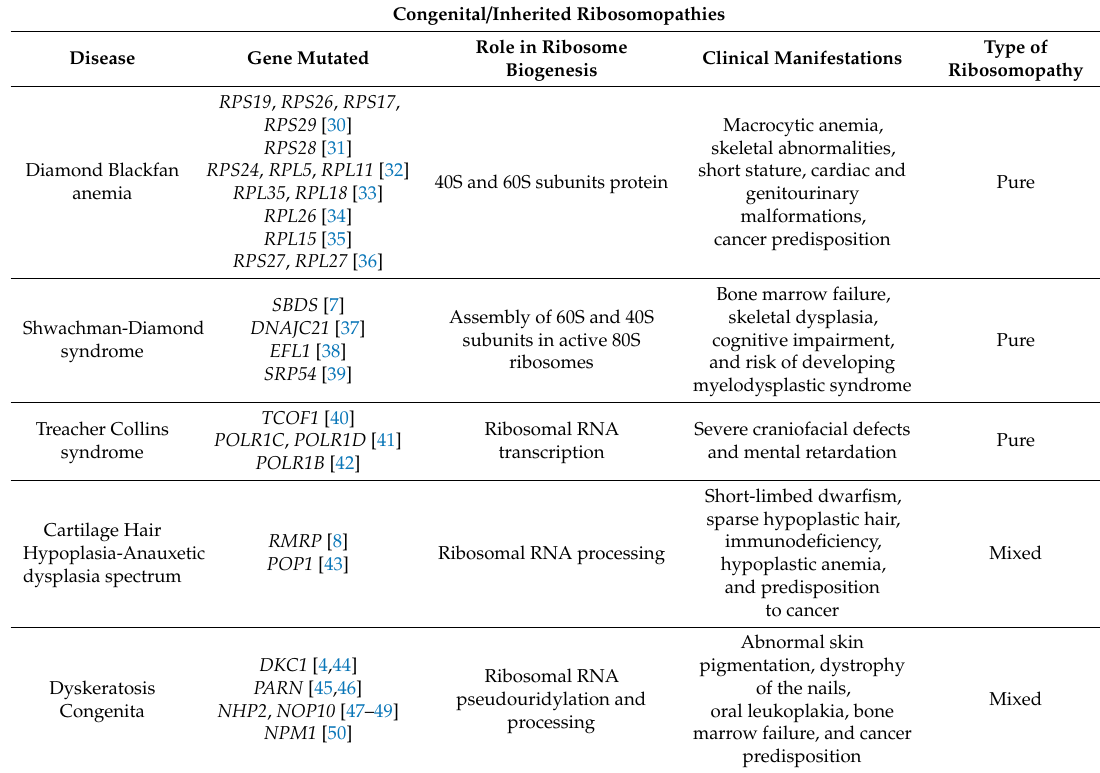
Table 1. Congenital / Inherited